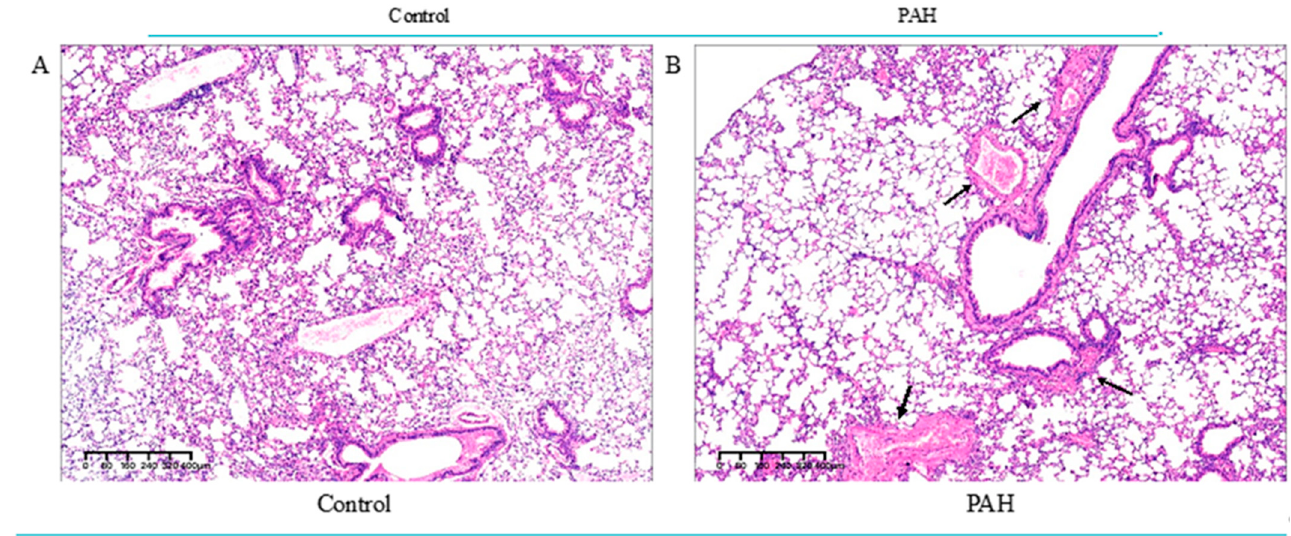
Figure 5. Histopathological sections of mouse lung tissue. ( A ) control group ( B ) PAH group. His- tomorphological and pathological findings showed thickened vessel walls and increased alveolar fusion in the lungs of PAH mice, with significant lesions in the lung tissue. The arrows indicate the thickening of the pulmonary arteriole wall, lumen stenosis, and proliferation of vascular smooth muscle cells.